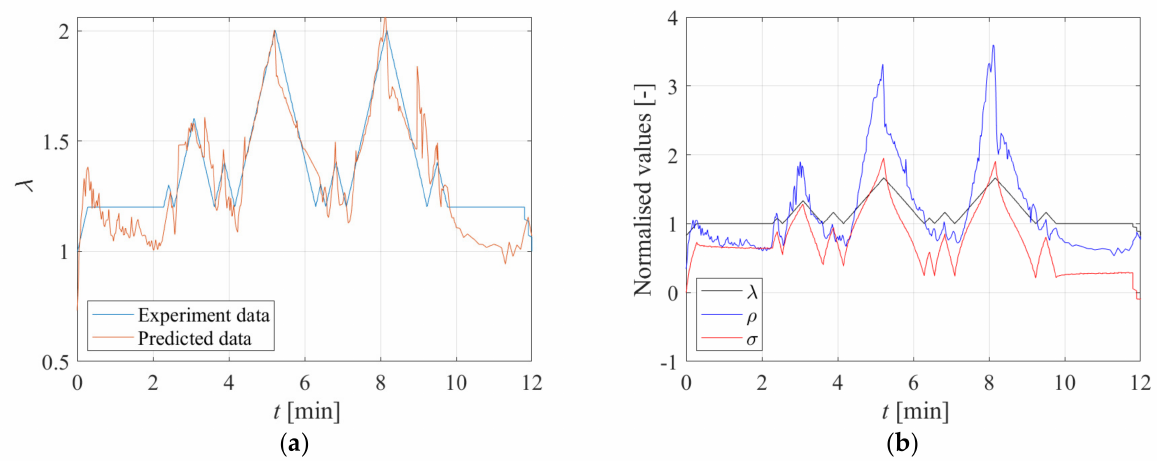
Figure 15. ( a ) Extension ratio vs. time: comparison between experiment and predicted data; ( b ) Time history of normalised displacement, stress, and electrical